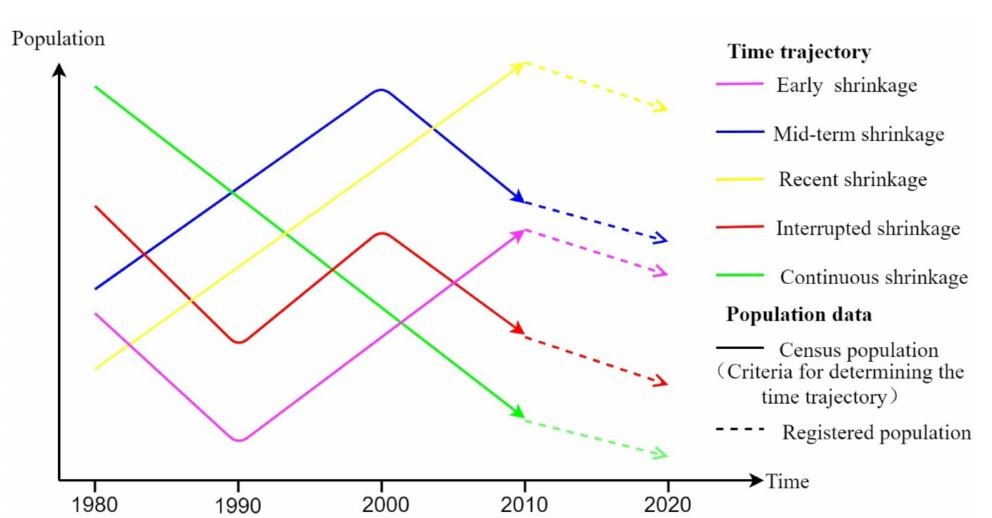
Figure 2. Time trajectories of shrinking